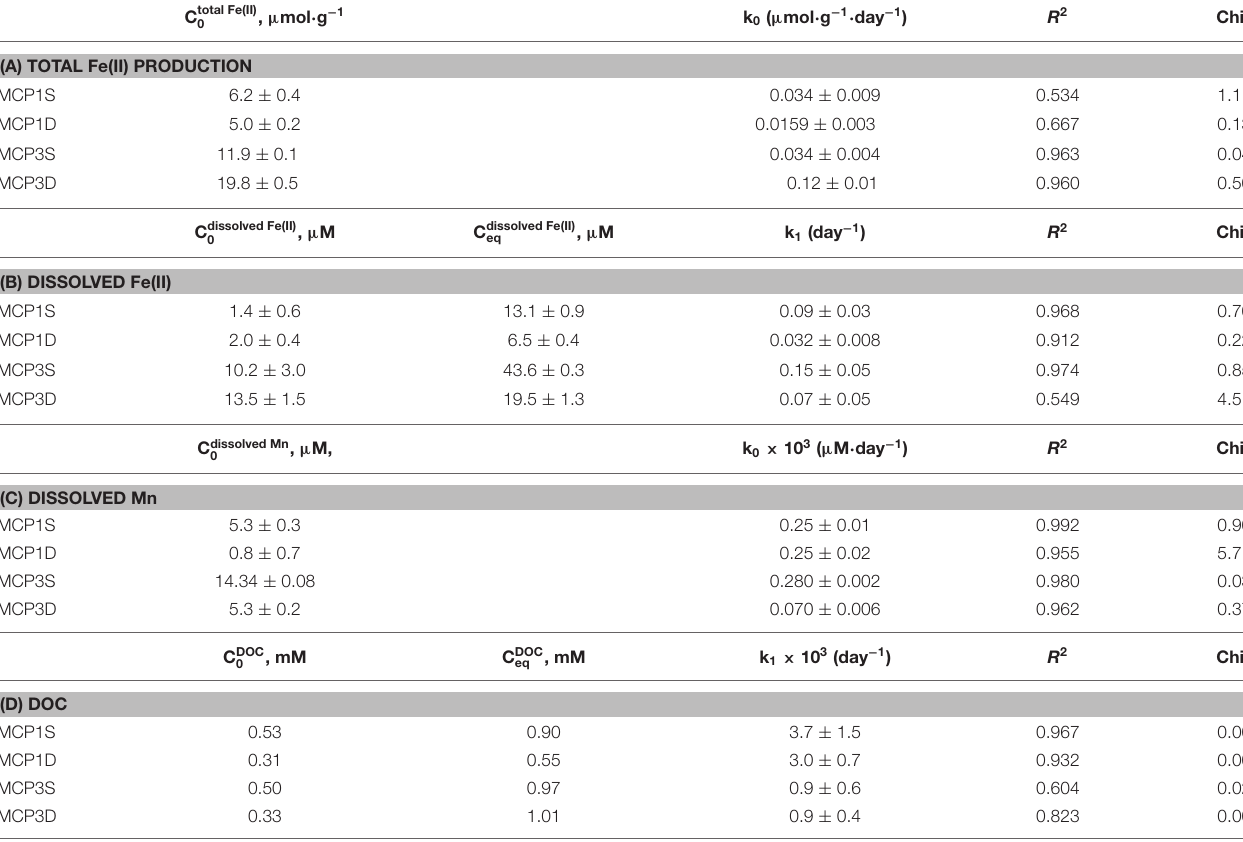
TABLE 4 | Fitted kinetic parameters of total Fe(II) production (A), and release of dissolved Fe (B), dissolved Mn (C), and DOC (D). C totalFe(II)